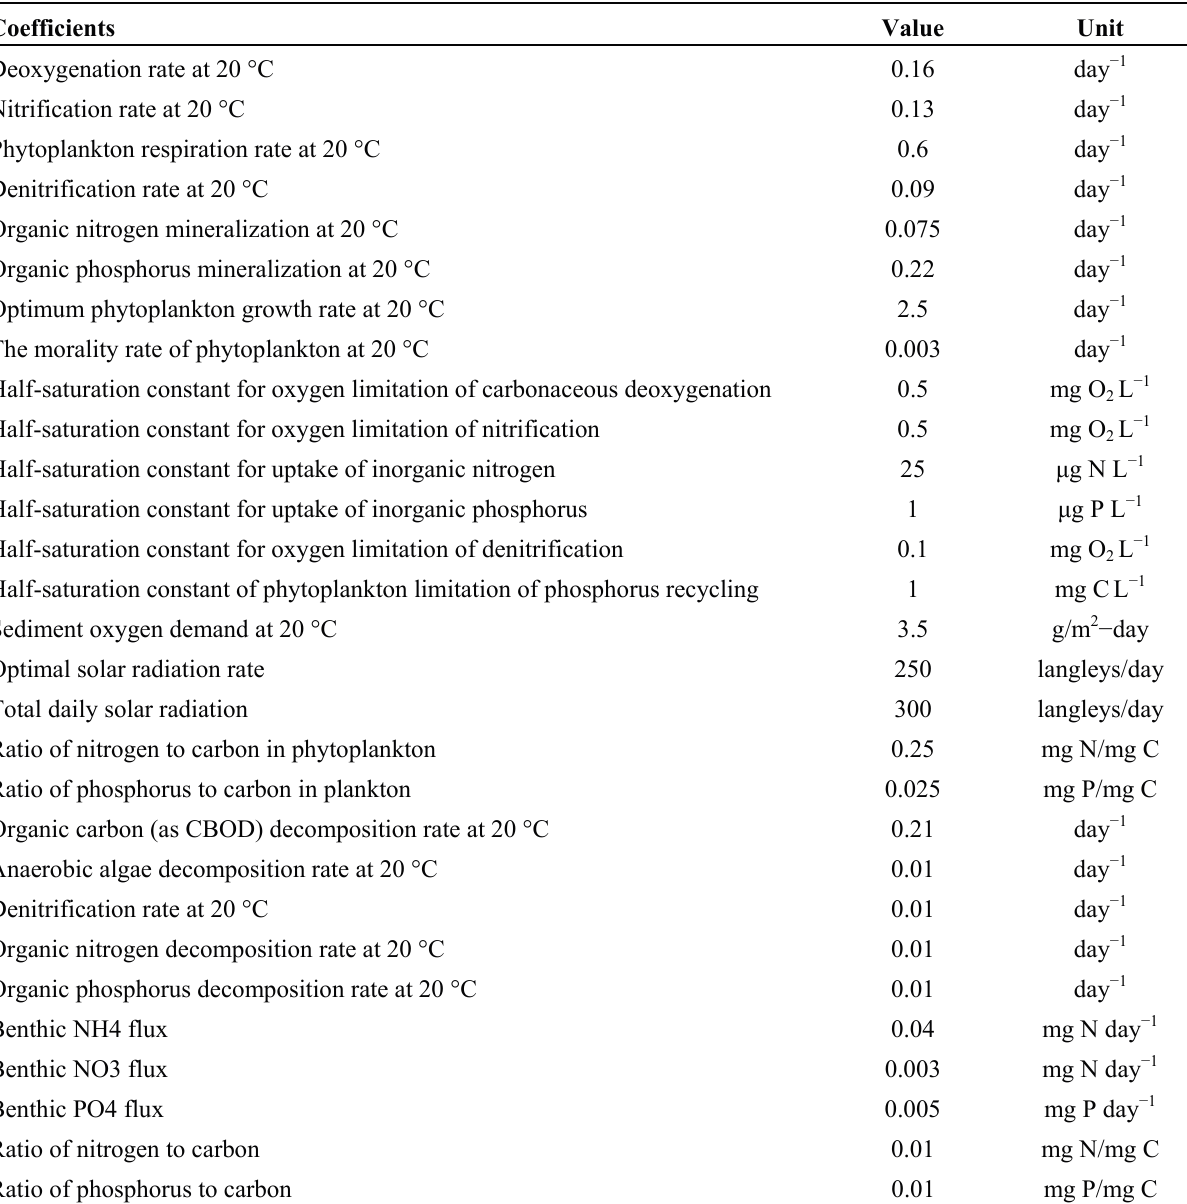
Table 2. Coefficients adopted in the water quality